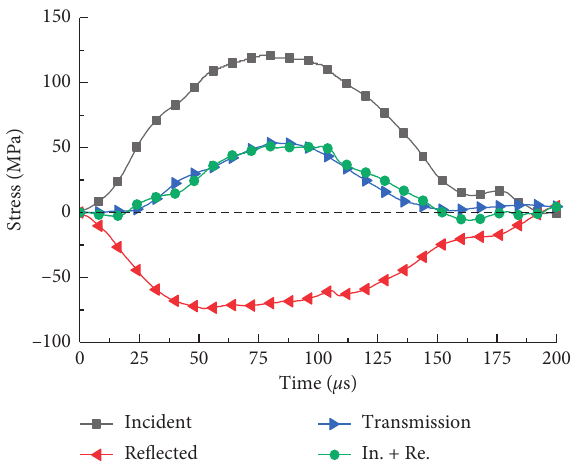
Figure 10: Stress balance diagram.